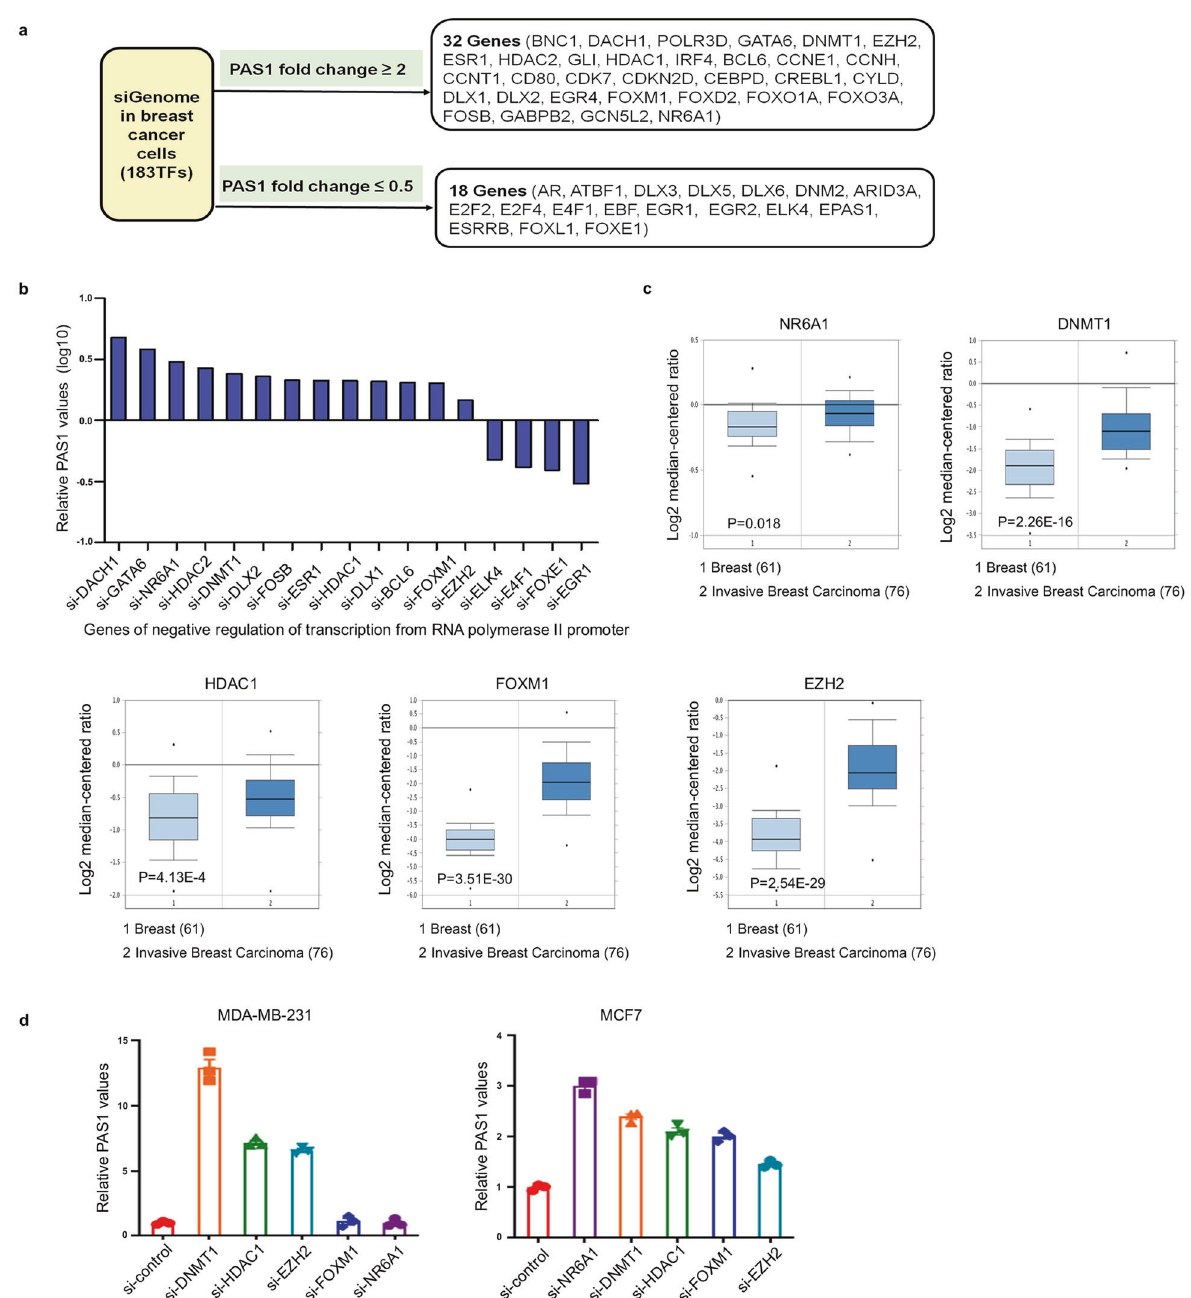
Fig. 1 Screening the transcript factors (TFs) that regulate PAS1. a Flow chart depicts the screening process. siRNAs of 183 TFs were transfected into breast cancer cell MCF7. After 72 h, total RNA was extracted, followed by qRT-PCR to detect the level of PAS1. b The TFs were fi ltered